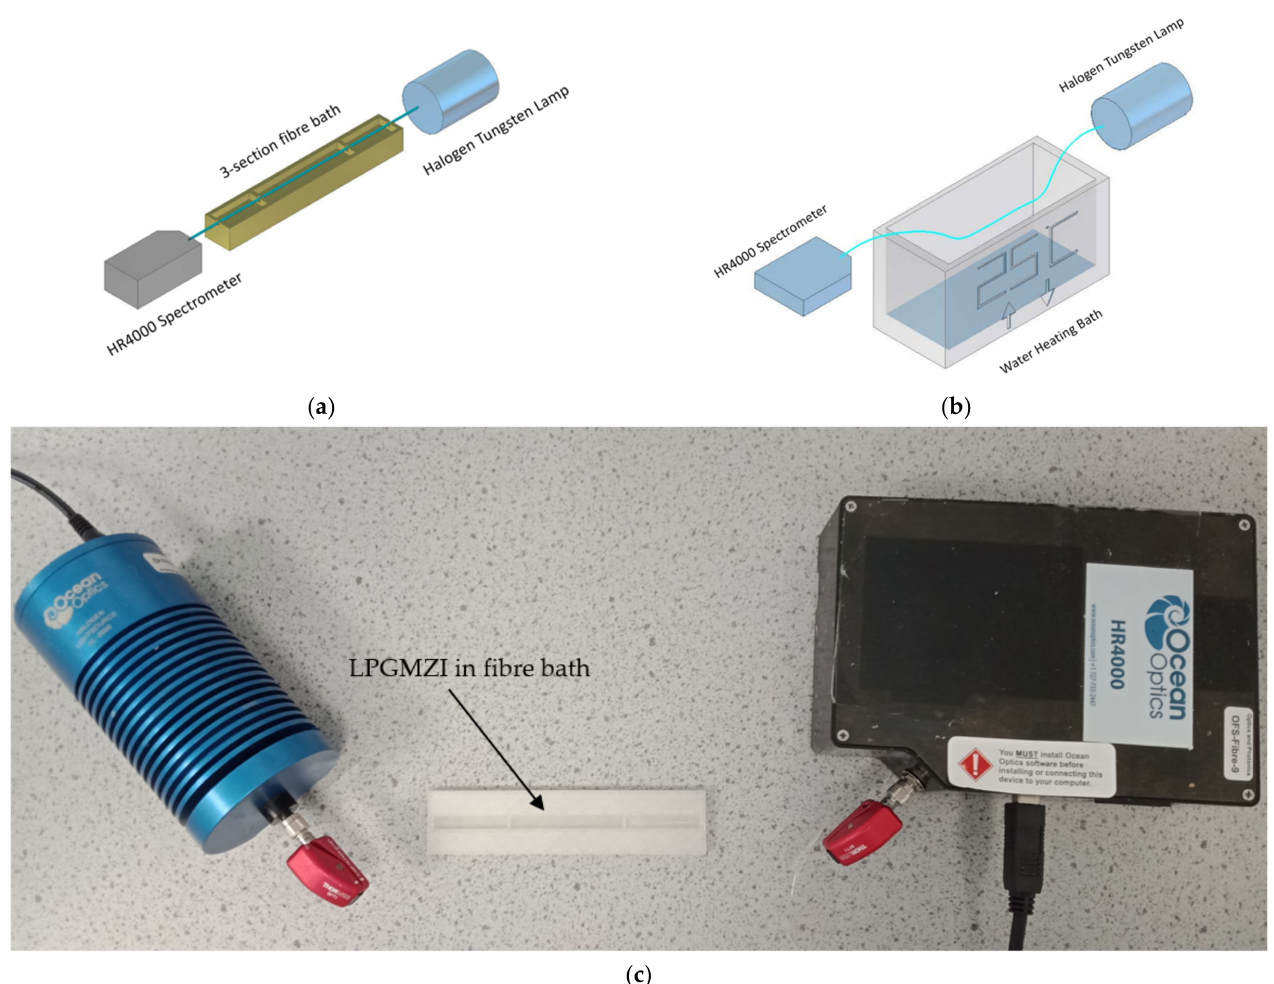
Figure 2. The experimental set-ups: ( a ) the LPGMZI in a 3-section fibre bath used for external RI measurement and IgM measurement (LPG sections 2.75 cm (L) × 0.5 cm (W) × 0.3 cm (H), middle section 4.5 cm (L) × 0.5 cm (W) × 0.3 cm (H); ( b ) the LPGMZI in a water heating bath used for temperature measurement (30 cm (L) × 15 cm (W) × 15 cm (H)); ( c ) the photo of